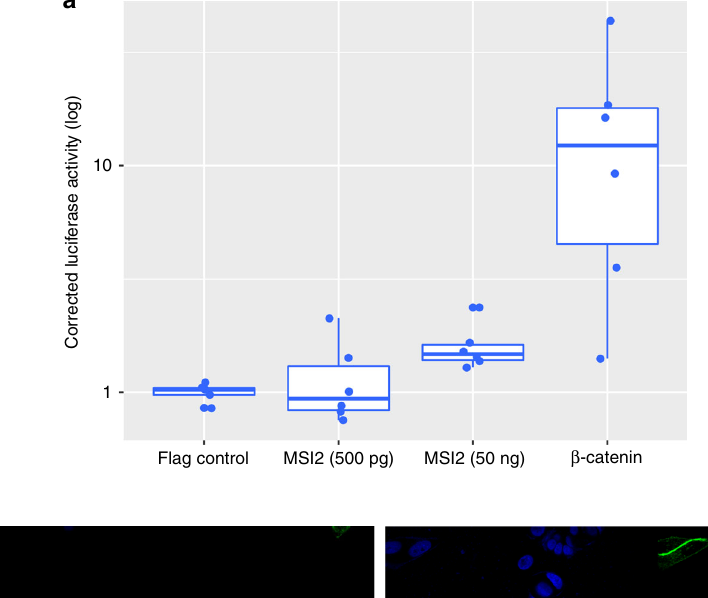
To characterise the functional consequences of increased MSI2 expression in vivo we used a transwell assay to evaluate migration. MSI2-GFP-expressing MCF7 cells exhibited a sig- ni fi cant 104% increase in migration relative to control cells expressing GFP alone (95% con fi dence interval = 11.6% to 198.4% increase; Welch ’ s t test; p < 0.05; Fig. 4a). The number of invasive cells also increased by 77% compared to the GFP controls in MCF7 (95% con fi dence interval = 23.6% to 130.8% increase; Welch ’ s t test; p < 0.05; Fig. 4b). Similar results were observed in the MDA-MB-231 cell line over-expressing a MSI2- GFP fusion (Welch ’ s t test; p < 0.05 for both; 193 and 291% increase for migration and invasion, respectively; Fig. 4c, d). The MSI2-knockdown MCF7 clones exhibited the reverse effect in the migration and invasion assays (Fig. 4e, f). The knockdown cell line was further assessed for proliferative capacity by the cell counts at different days. By day 5, MSI2-knockdown cells exhibited signi fi cantly decreased proliferative capacity, in contrast to the controls (Welch ’ s t test; p < 0.05; Supplementary Fig. 3).